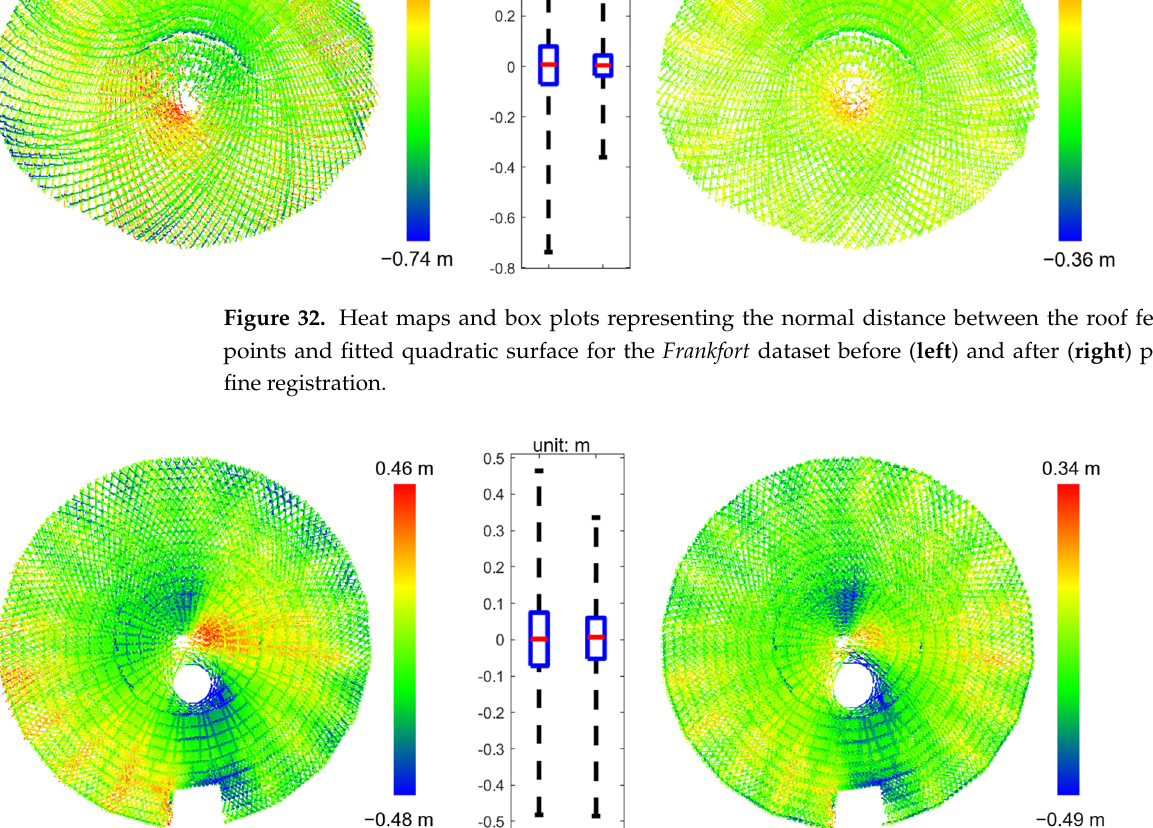
Figure 33. Heat maps and box plots representing the normal distance between the roof feature points and fitted quadratic surface for the West Lafayette dataset before (left) and after (right) partial fine registration.